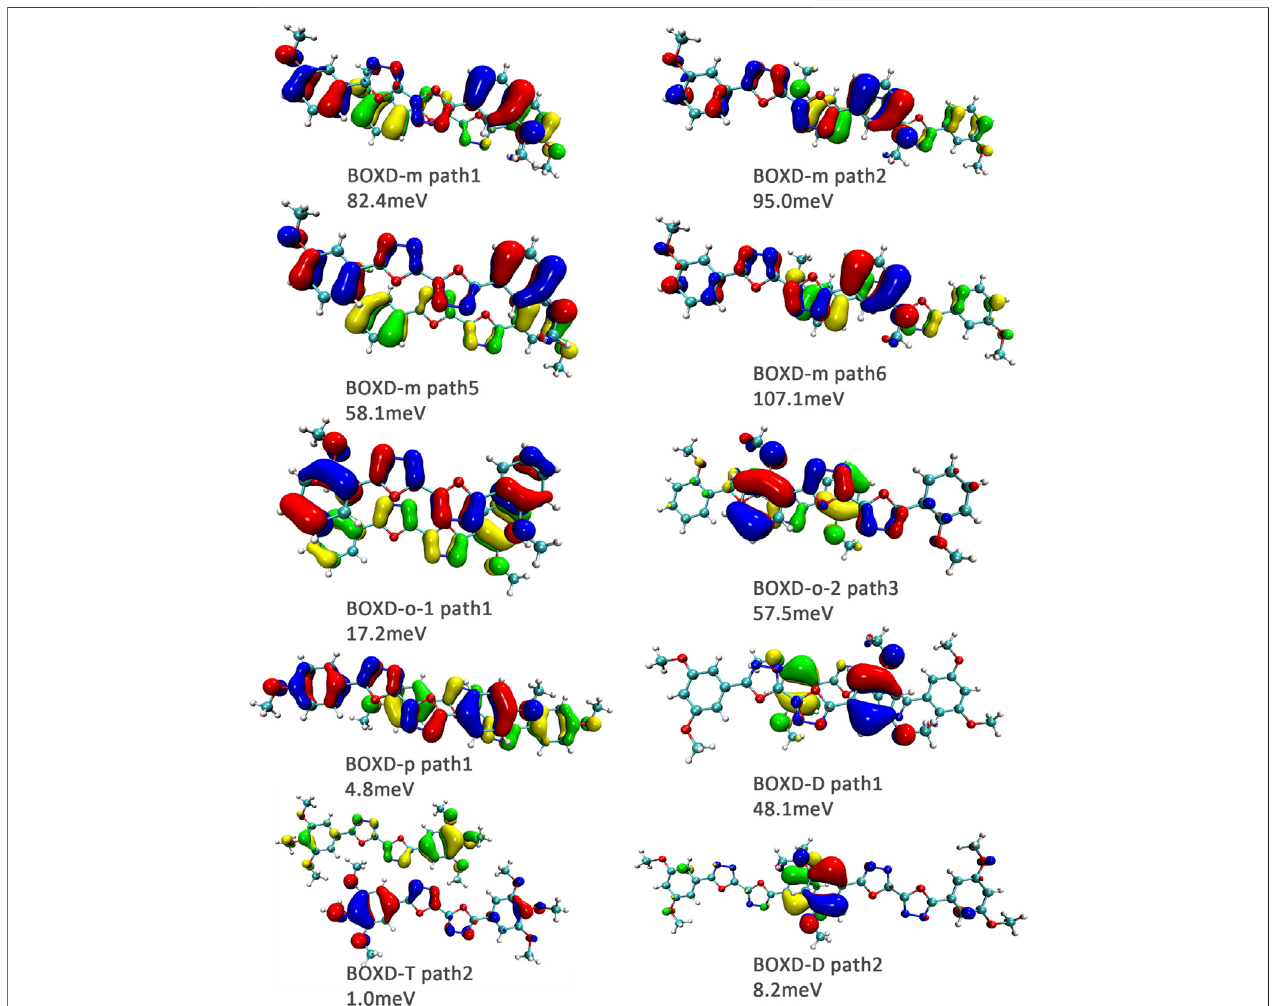
FIGURE11| Bimolecular orbitaldistributionofprimaryholetransferpathsin π stacking.Thepositivephaseisdepictedinredandyellow,and thenegativephaseis depicted in blue and green.